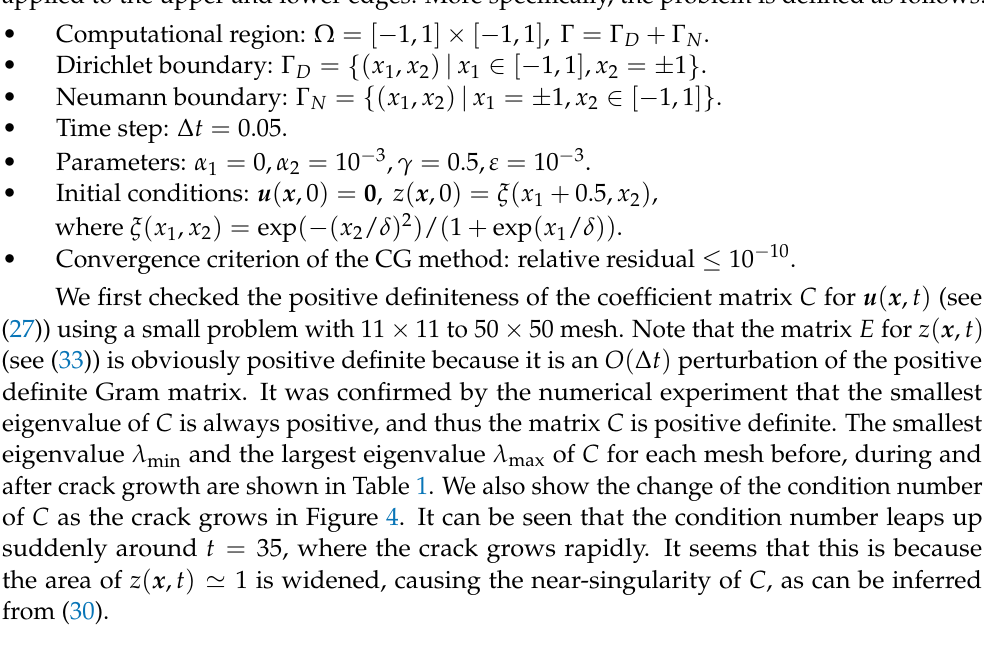
Table 1. The smallest and the largest eigenvalues of C for each